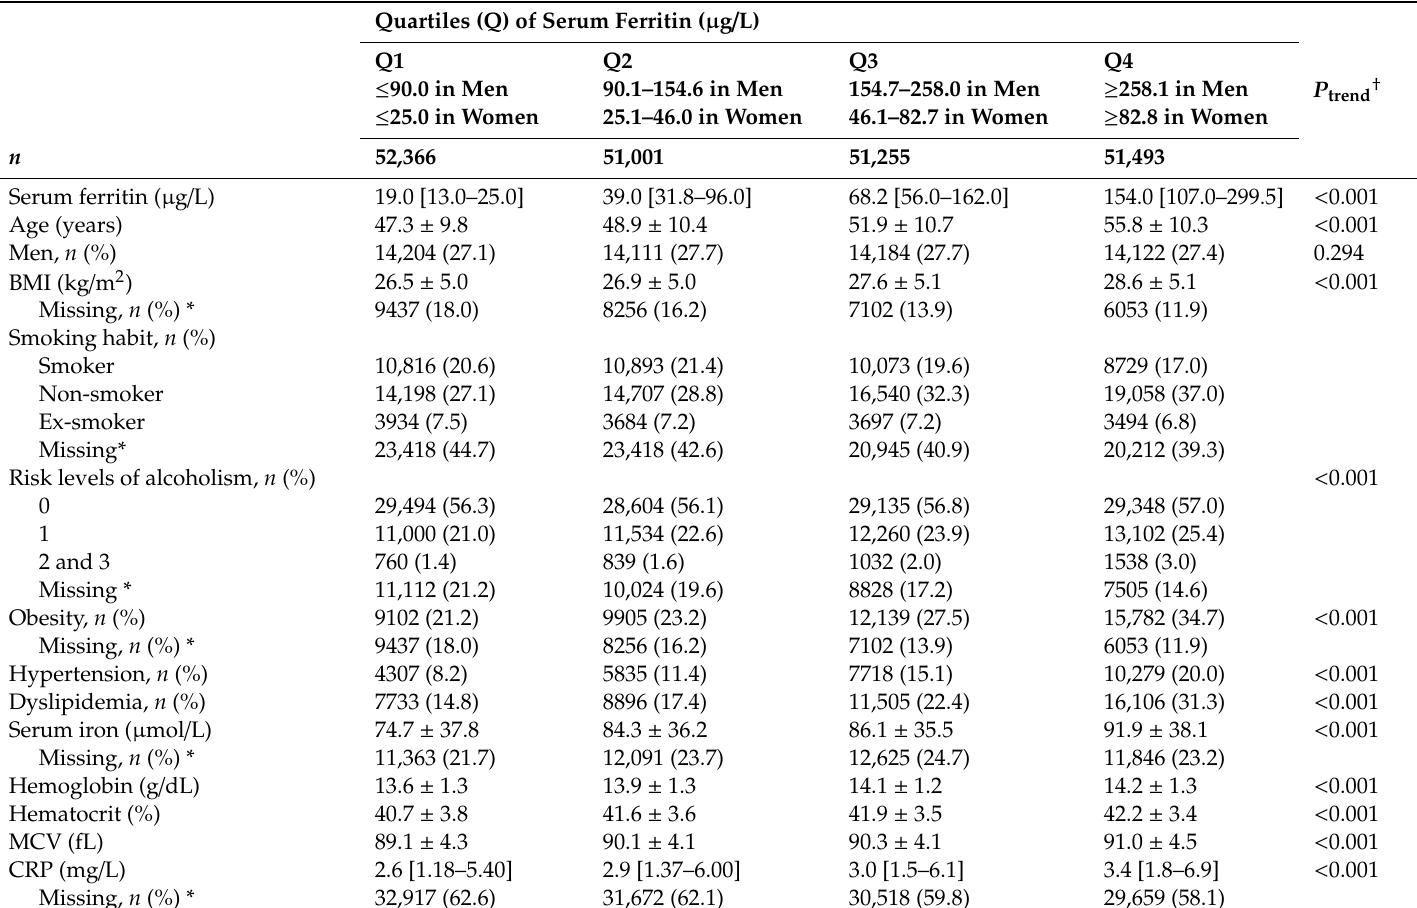
Table 2. Baseline characteristics of study subjects according to sex-specific quartiles of serum ferritin concentrations ( n =